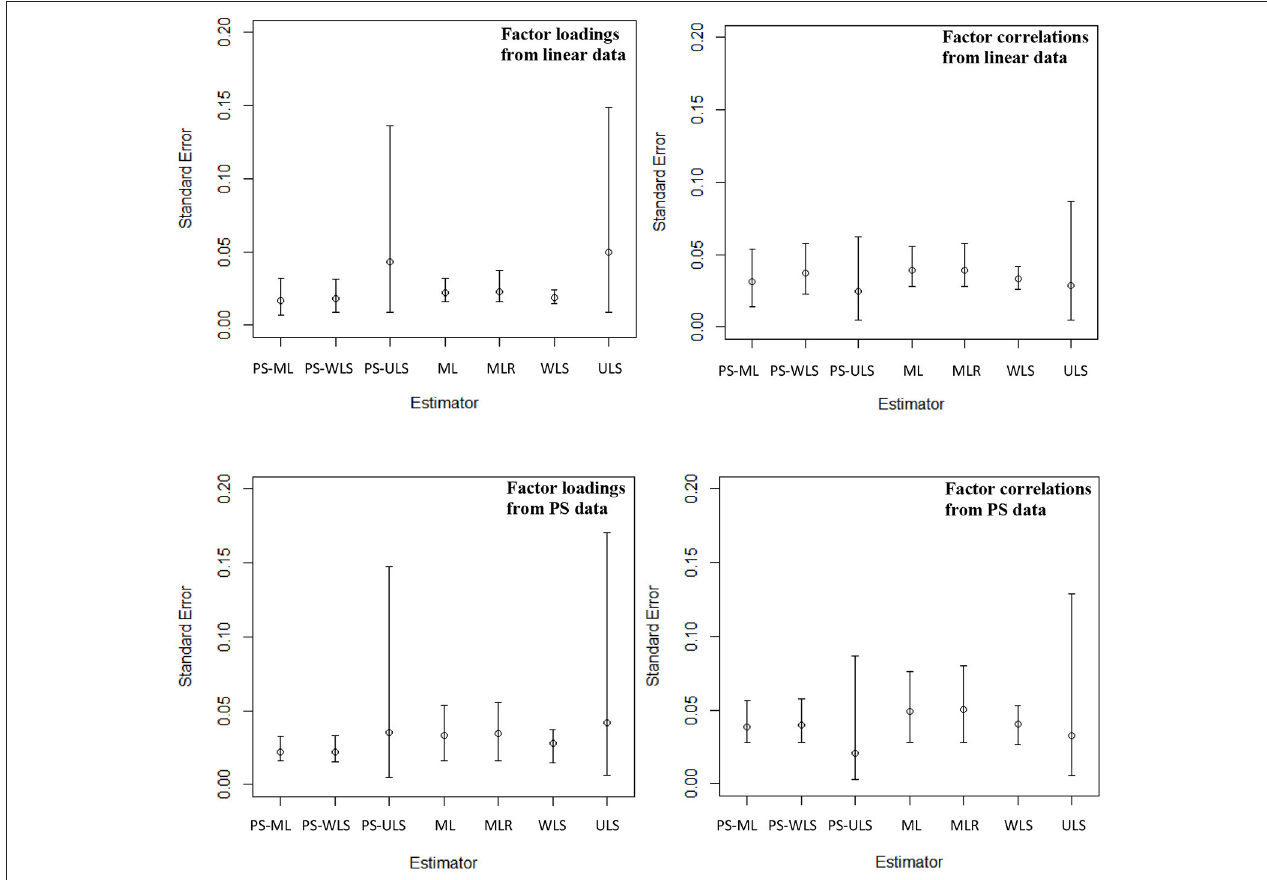
FIGURE 5 | Standard errors of the factor loadings and factor correlations across 40 conditions. The top left panel shows the mean, min, and max of the standard errors of 20 factor loadings across 40 conditions, and the top right panel shows the mean, min, and max of the standard errors of 6 factor correlations across 40 conditions, when data are linear-based. The bottom left panel shows the mean, min, and max of the standard errors of 20 factor loadings across 40 conditions, and the bottom right panel shows the mean, min, and max of the standard errors of 6 factor correlations across 40 conditions, when data are PS-based.